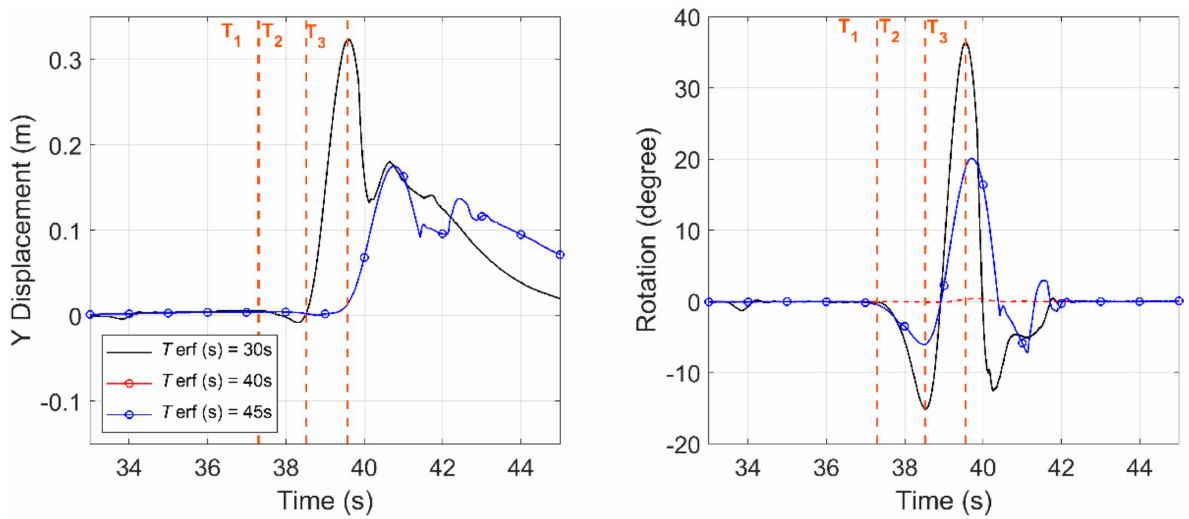
Figure 14. Numerical results of the free debris: vertical displacement ( left ) and rotation ( right ), for h 1 = 2.496 m and three wave cases with T erf = 30, 40, and 45